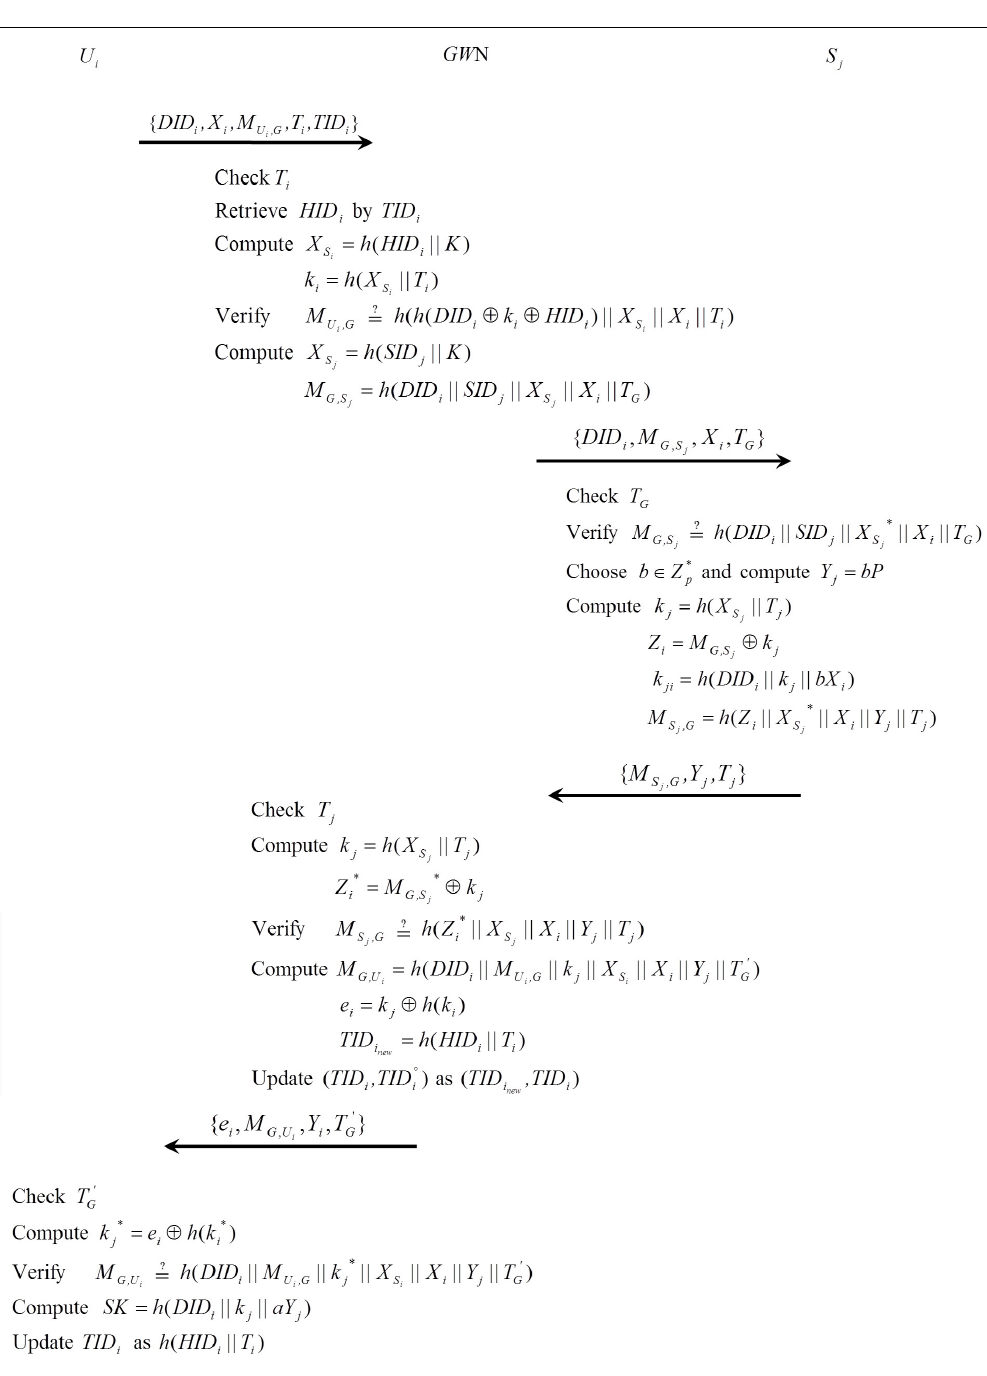
Figure 3. Authentication and key agreement